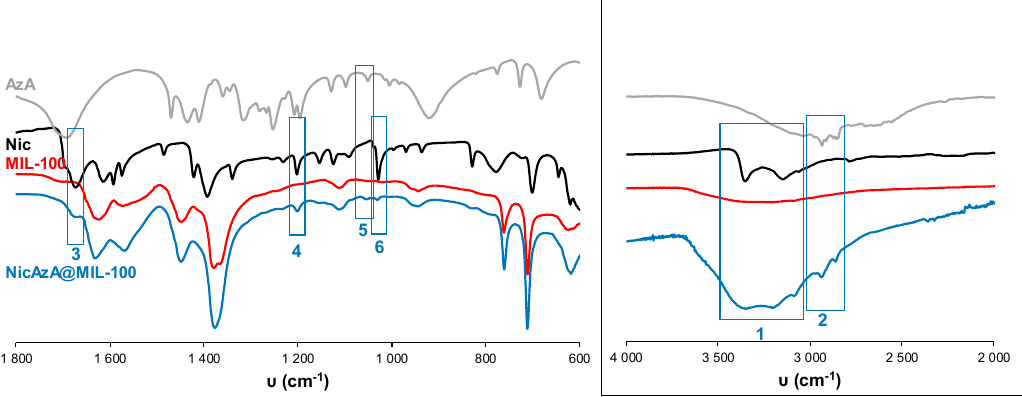
Figure 5. FT - IR spectra of empty MIL-100 and drugs-loaded NicAzA@MIL-100. The spectra of free drugs (Nic and AzA) have been included for comparison. FT - IR spectroscopic analysis clearly showed the presence of Nic and AzA into the NicAzA@MIL-100 loaded matrix: Nic δ (N-H) (3), Nic ν (C-NH 2 ) (4), AzA ν (C-O) (5), and Nic δ (C-H) (6) bands. The inset shows a spectra magnification with the Nic ν (N-H) (1) and AzA ν (C-H) – ν (OH) (2) bands [70–72].